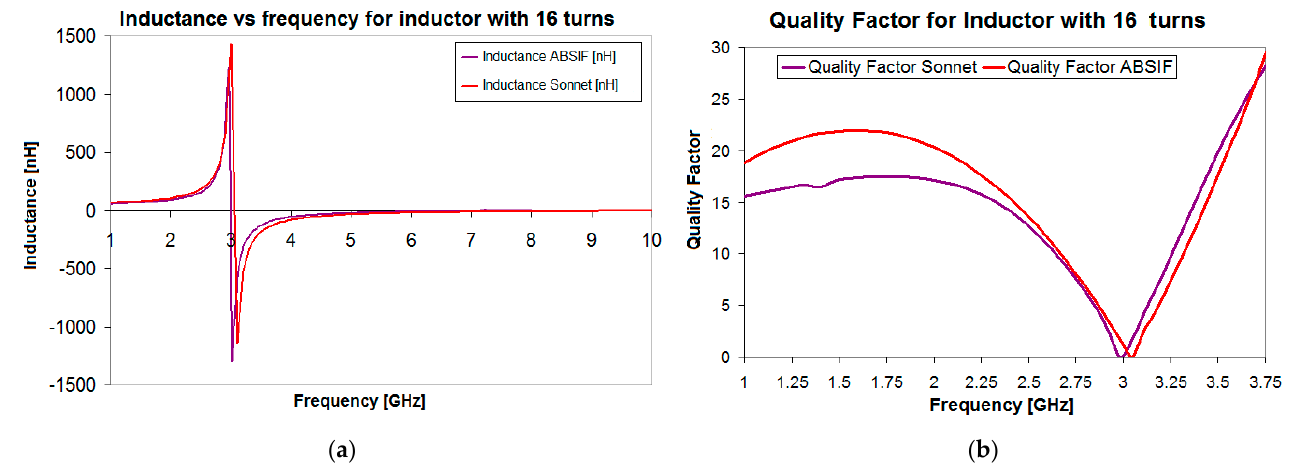
Figure 5. Comparison of the results for 16 turns square spiral inductor: ( a ) inductance; ( b ) quality factor.